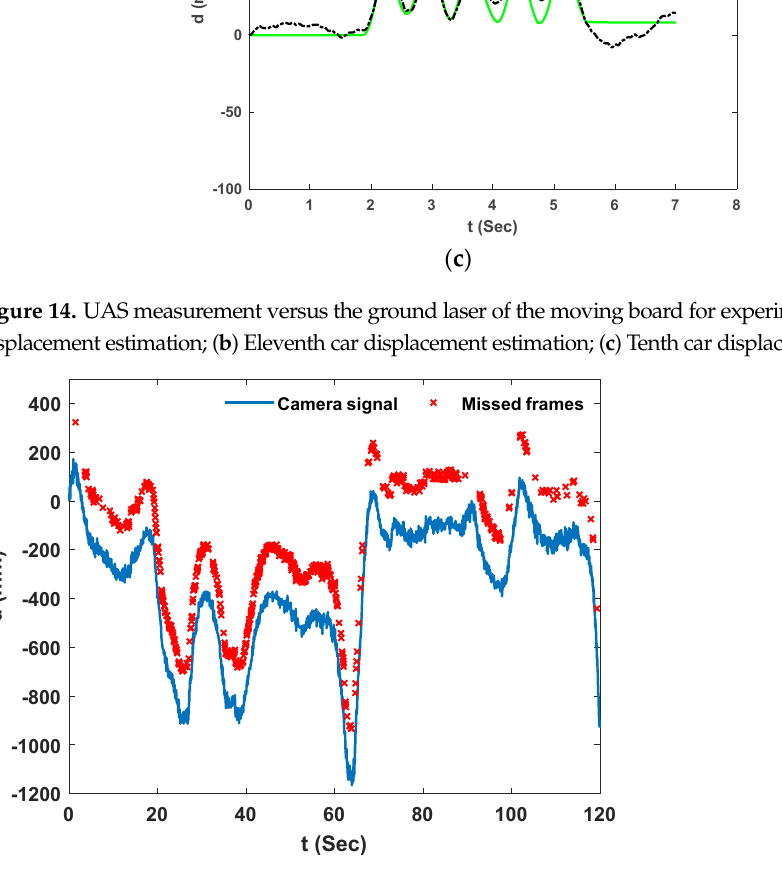
Figure 15. Camera signal in Y direction and the missed experiment frame, experiment 5.